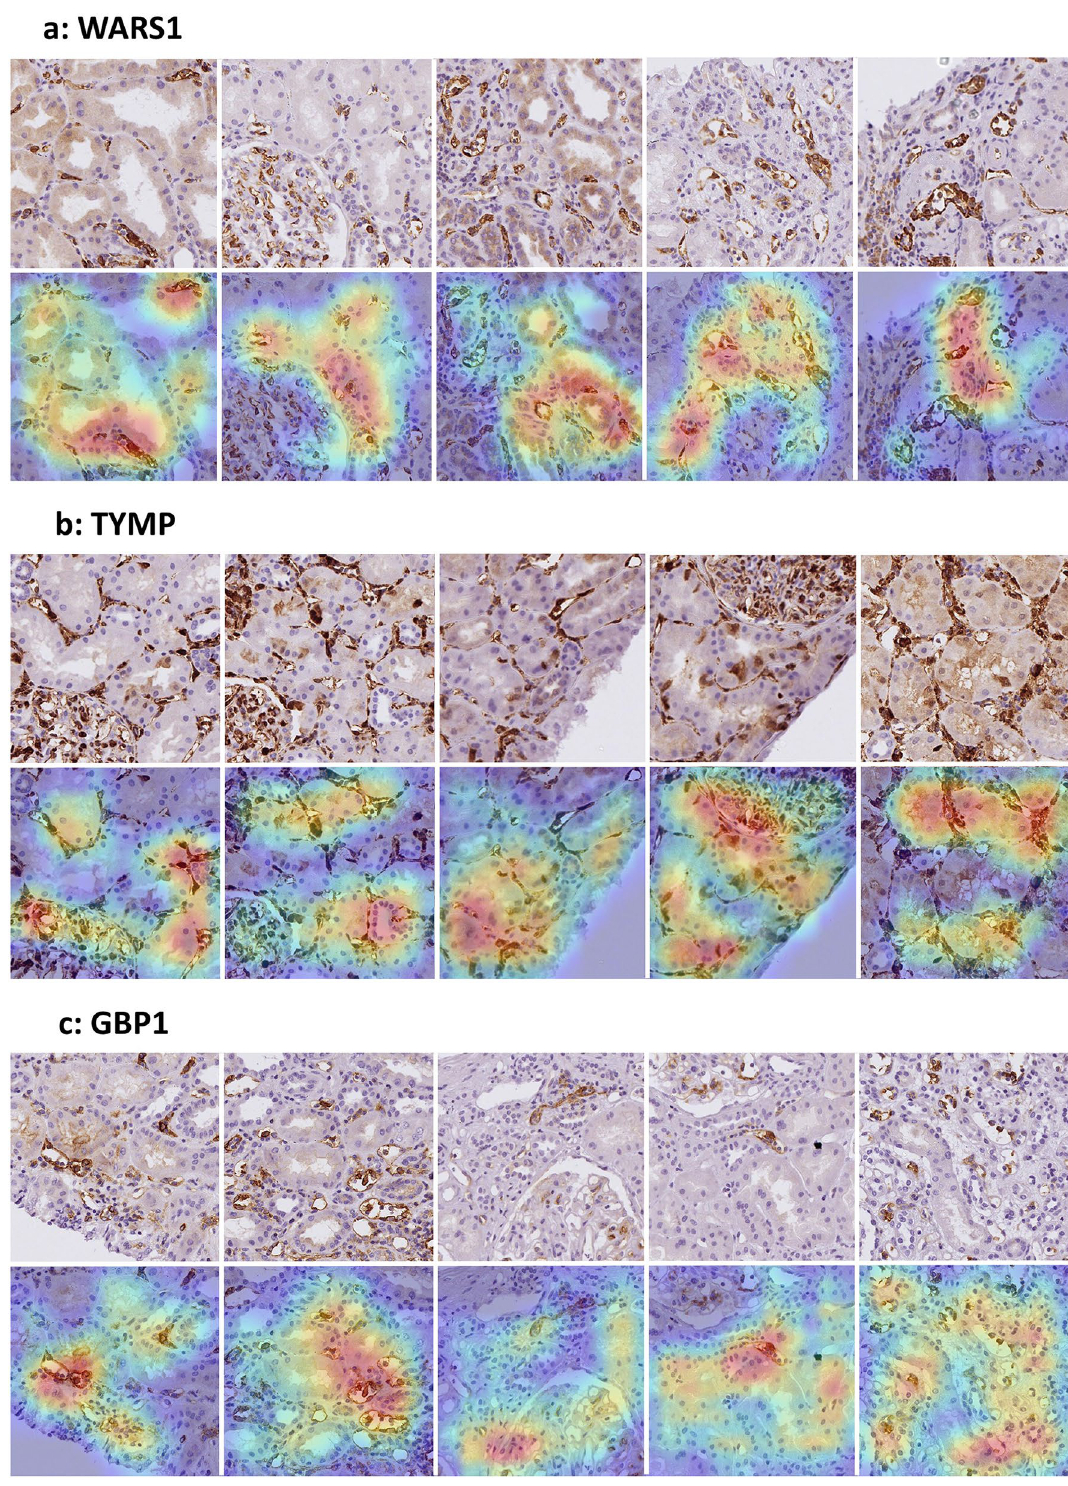
Figure 3. Illustrative morphological patterns of ( a ) WARS1, ( b ) TYMP and ( c ) GBP1 associated by the convolutional neural network with the active ABMR class, using the Grad-CAM approach. For each antibody, 5 tiles (512 × 512 pixels) among the most associated with the ABMR class are displayed, with the corresponding heatmap presented below (from blue to red, where red represents regions of utmost importance by the neural network for class consideration). Notice that, for each antibody, the neural network focused on capillaries lined by moderately to strongly stained endothelial cells, sometimes associated with inflammatory cells, and particularly considering peritubular capillaries, rarely glomerular capillaries. Endothelial staining is diffuse with WARS1 and TYMP, focal with